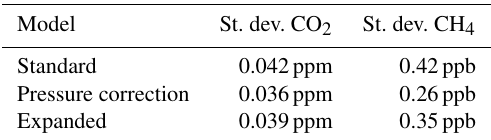
Table 8. Average standard deviations of dry air mole fractions from all droplet experiments with Picarro no. 1 based on the three water correction